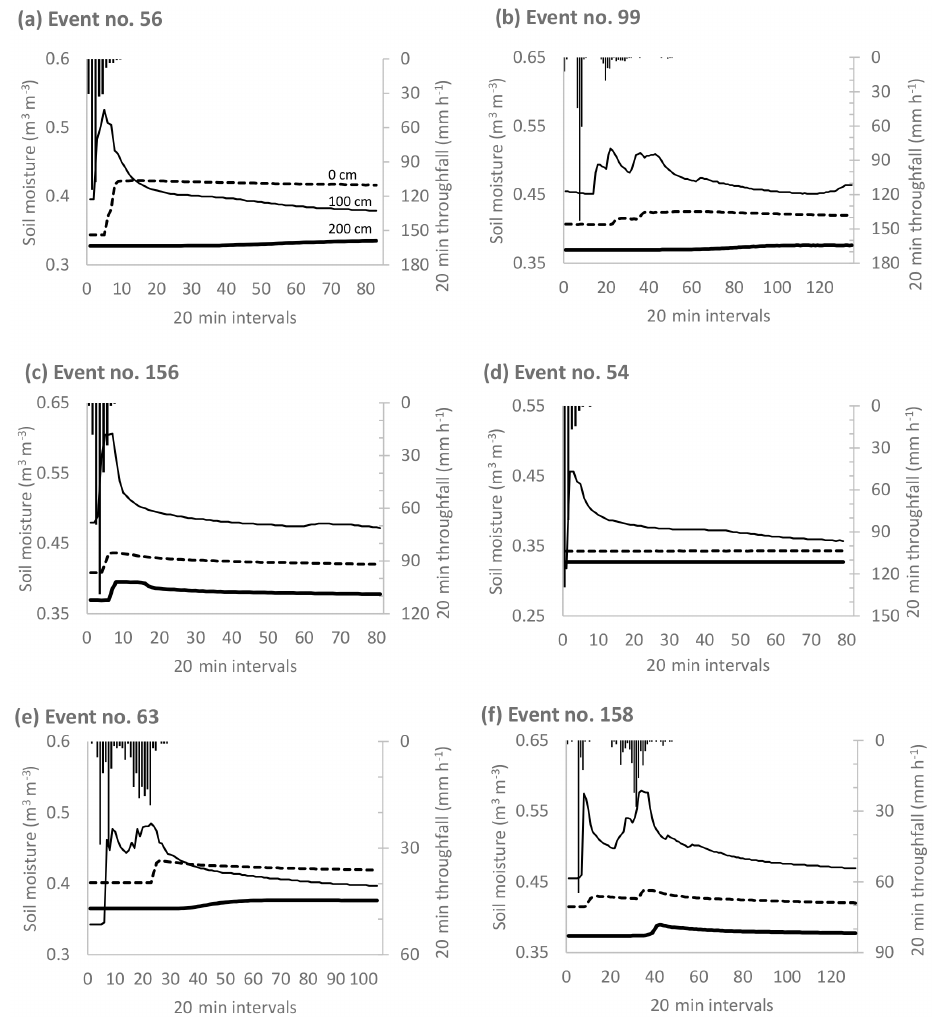
Figure 6. Volumetric soil moisture response at three depths during the six largest events (Table 2). Events with initial surface soil moisture (0cm) ≥ 0.40m 3 m − 3 are considered to have wet antecedent conditions: 56 (116mm of rainfall); 99 (111mm); 156 (89mm); and 158 (78mm). The other two events, 54 (81mm) and 63 (77mm), are associated with drier antecedent moisture conditions ( ≤ 0.30m 3 m − 3 ) . All data are plotted as 20min aggregated values. Soil moisture curves in all panels correspond to surface (thin line), 1m (dashed line), and 2m (thick line) depths (key shown in panel a ). Each rainfall bar represents a 20min